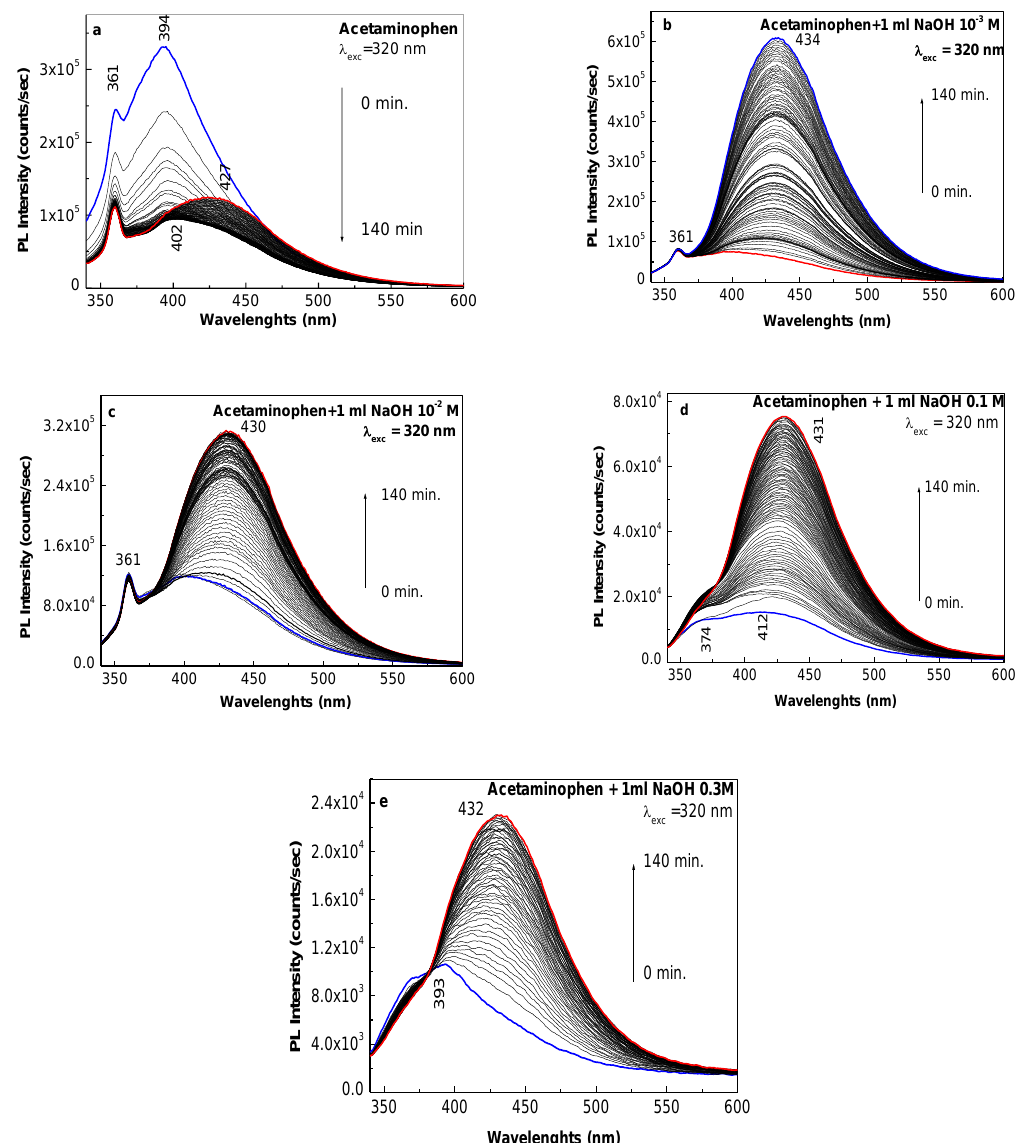
Figure 2. The photoluminescence (PL) spectra of the aqueous solution of AC before ( a ) and after the interaction with the aqueous solution of NaOH 10 − 3 ( b ), 10 − 2 ( c ), 10 − 1 ( d ) and 3 × 10 − 1 M ( e ). All PL spectra were recorded at the excitation wavelength of 320 nm. Blue and red curves correspond to the first and last spectrum, respectively, of the samples exposed to UV light for 0 and 140 min. Black curves correspond to the intermediate spectra of above samples, each PL spectrum being collected at 140 s, respectively.